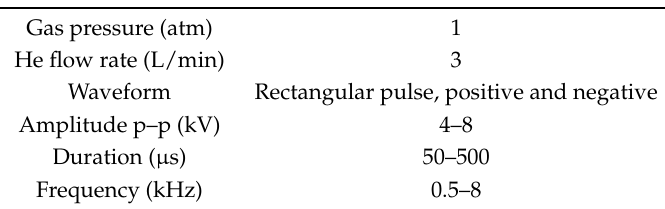
Table 1. Operational parameters of the helium plasma